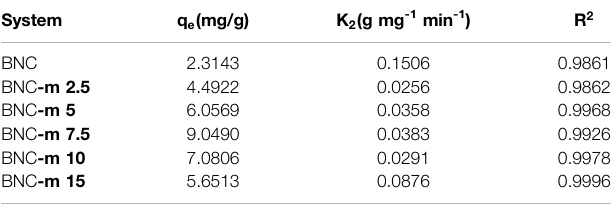
TABLE 6 | Kinetic parameters for the pseudo-second-order model.